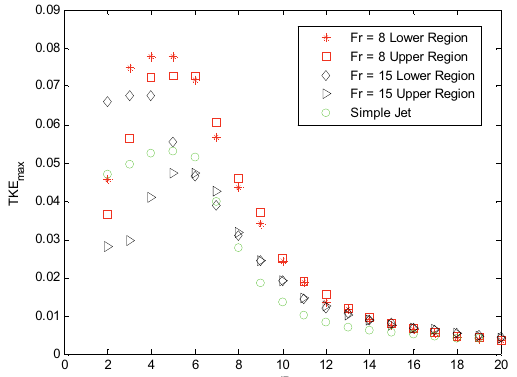
Figure 6. Streamwise decay of the maximum non- dimensional Turbulent Kinetic Energy TKE/U max2 in the upper (squares Fr=8, triangles Fr=15) and lower (asterisks Fr=8, rhombi Fr=15) region of the near-field of an INBJ with Re = 1000, θ = 65° and different Fr and of a simple jet with the same Re (green circles).